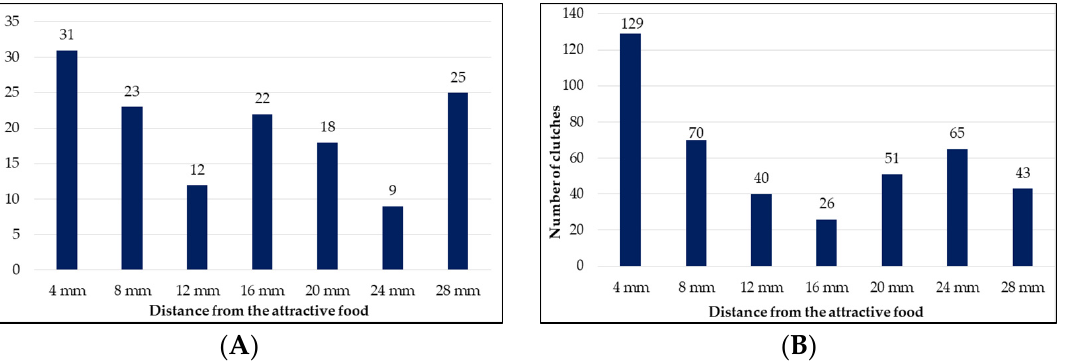
Figure 3. Distribution of the numbers of clutches according to the distance from the substrate in the two experimental stages. ( A ) Stage I, 140 oviposition (N = 500 flies); ( B ) Stage II, 424 oviposition (N = 1000 flies).